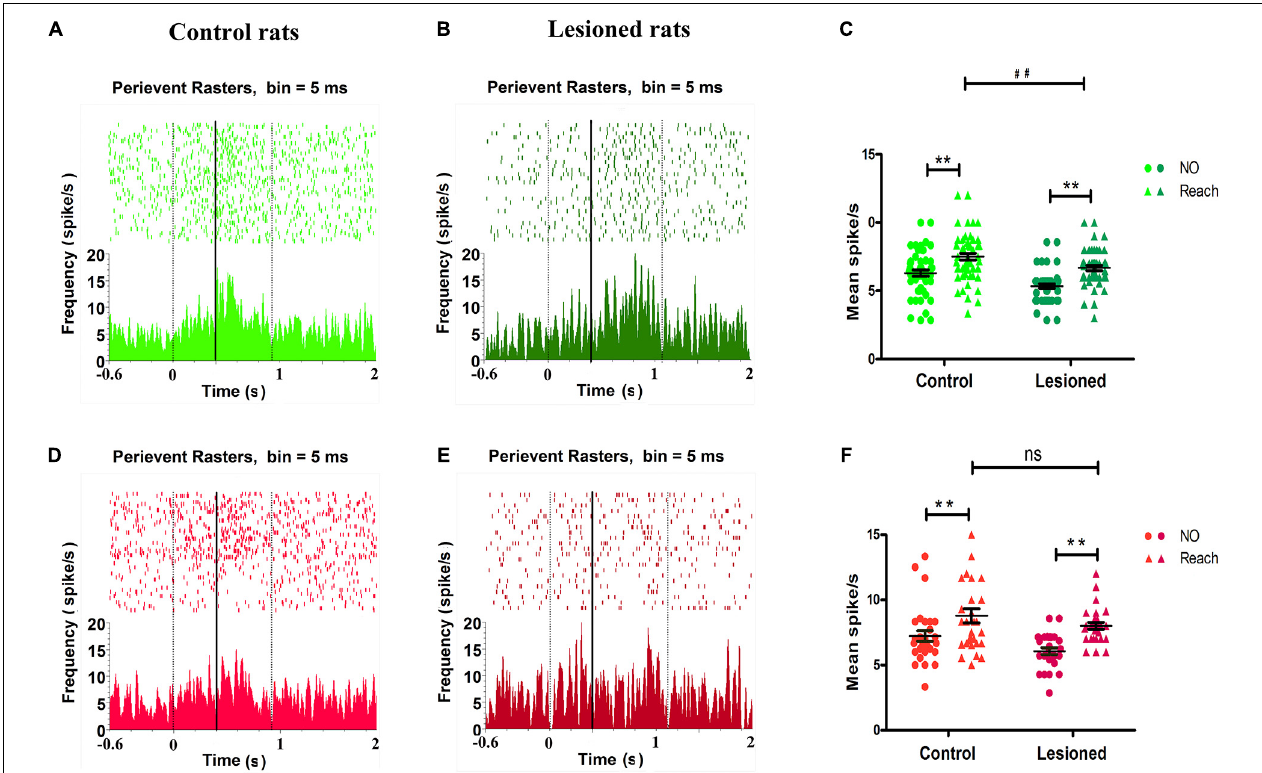
FIGURE 7 | Impact of DA cell loss on different M1 type neurons activity in reaching movement. Illustrative examples of peri-event raster plots (top) and PSTHs (bottom) during baseline and movement in control rats (A,D) and in 6-OHDA-treated rats (B,E) for spike firing activities in BS (light green for control rat, dark green for 6-OHDA-treated rat) and NS (light red for control rat, dark red for 6-OHDA-treated rat), respectively. The accumulated histogram of spike activity (spike/s, bin width 5 ms) across trials is shown below each raster plot. The time epochs of successful reach were limited to the two black vertical dotted lines. The black vertical solid line indicated the time that rat handled limb advancement and broke the infrared ray, time = 0 indicated the point of time when the rat just lifted its paw. The basal line (background) is the time from –0.6 s to 0. The dots and trigons of scatter plot represent the average firing rate for each neuron in control (left) rats and depletion (right) rats (C,F) . BS showed their firing rates’ modulation difference for control rats (light green, n = 57 neurons) and 6-OHDA-treated rats (dark green, n = 55 neurons) during background (Not reaching, dots) or catching movement (Reaching, trigons) (C) . NS showed their firing rates’ modulation difference for control rats (light red, n = 29 neurons) and 6-OHDA-treated rats (dark red, n = 28 neurons) during background (Not reaching, dots) or catching movement (Reaching, trigons) (D) . (C,F) Show data comparing control and 6-OHDA-treated groups during not catching and reaching behavioral tasks, ** indicates p < 0.01, for effects of behavior or background, and ## indicates p < 0.01 for effects of behavior between control and 6-OHDA-treated rats, respectively. Black lines represent grand mean SEM over all